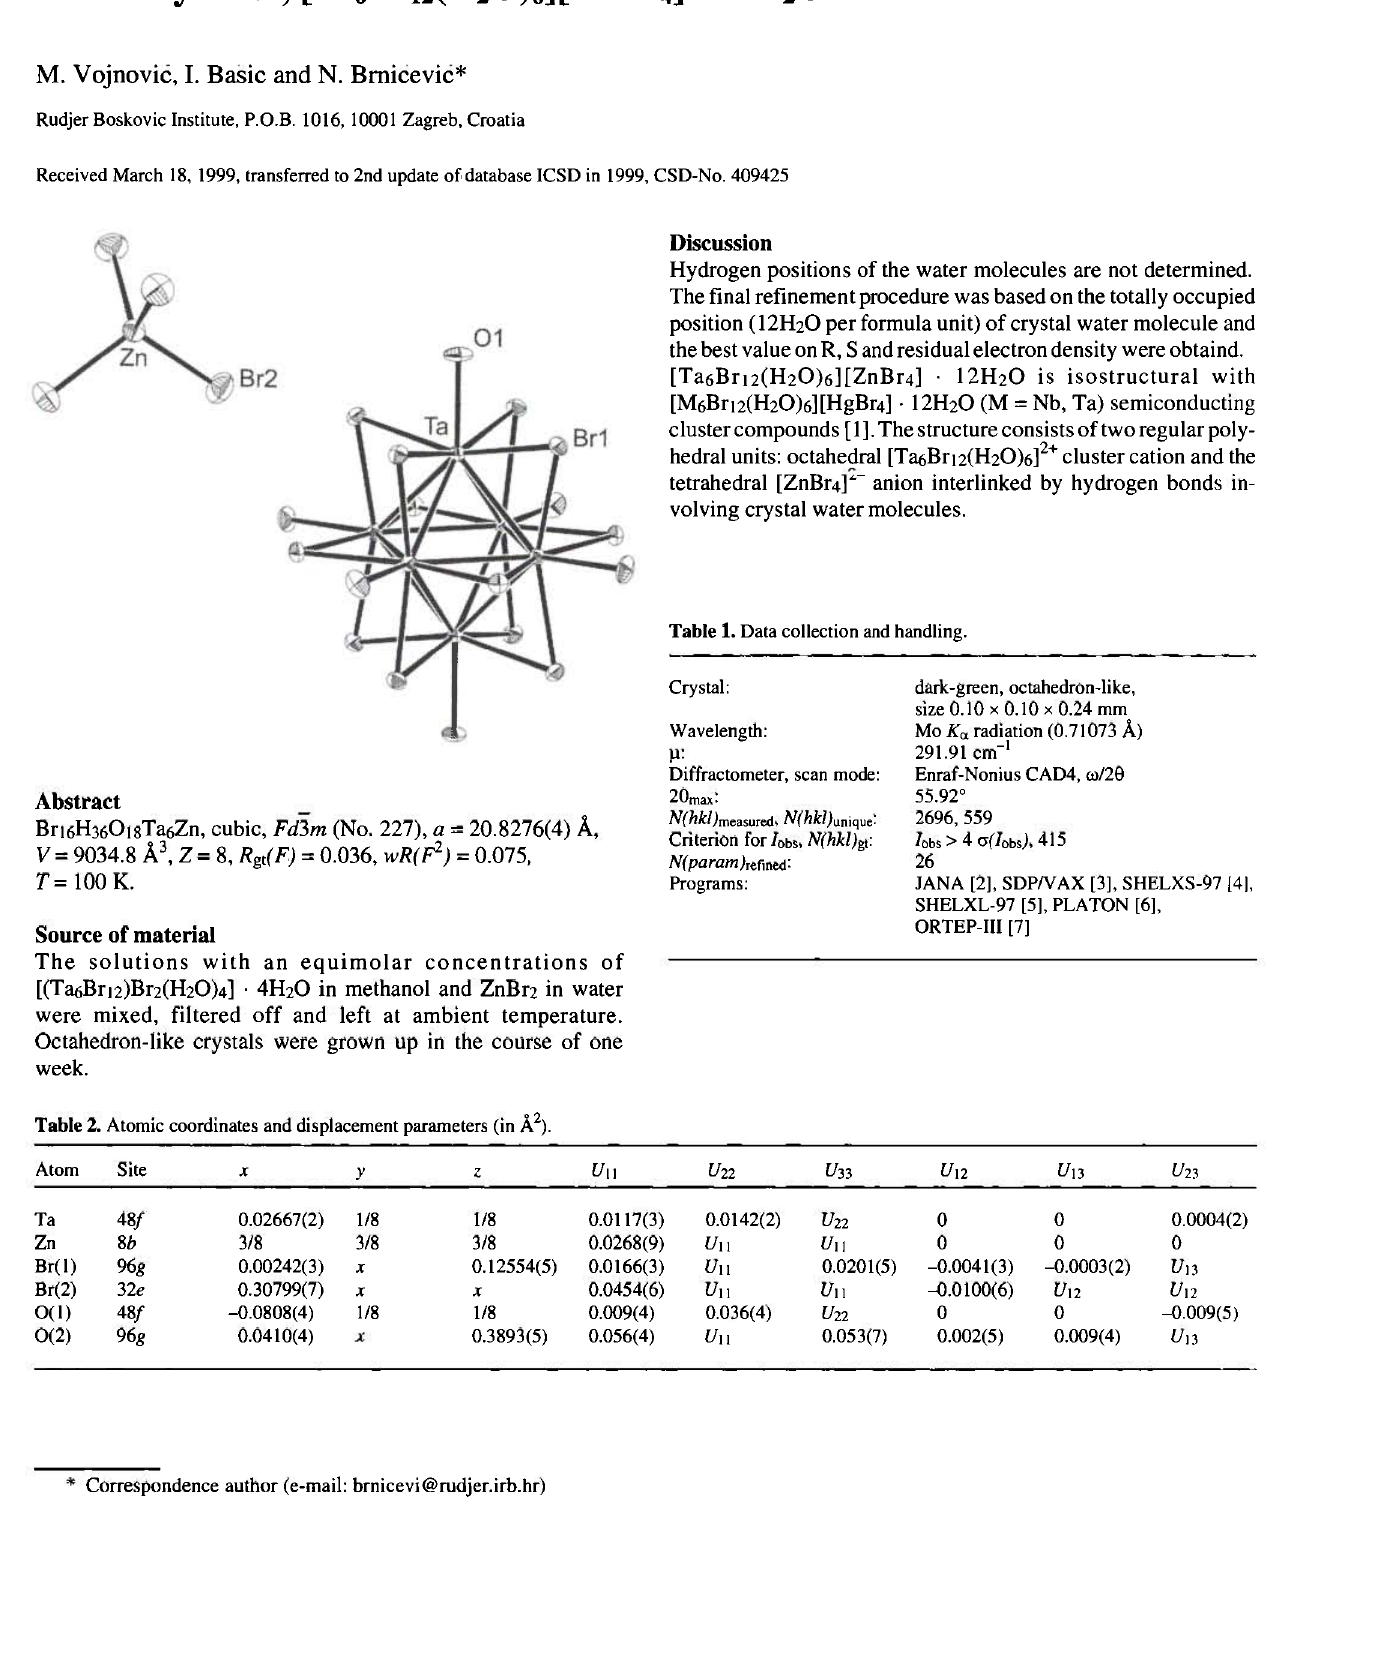
Discussion Hydrogen positions of the water molecules are not determined. The final refinement procedure was based on the totally occupied position (I2H2O per formula unit) of crystal water molecule and the best value on R, S and residual electron density were obtaind.